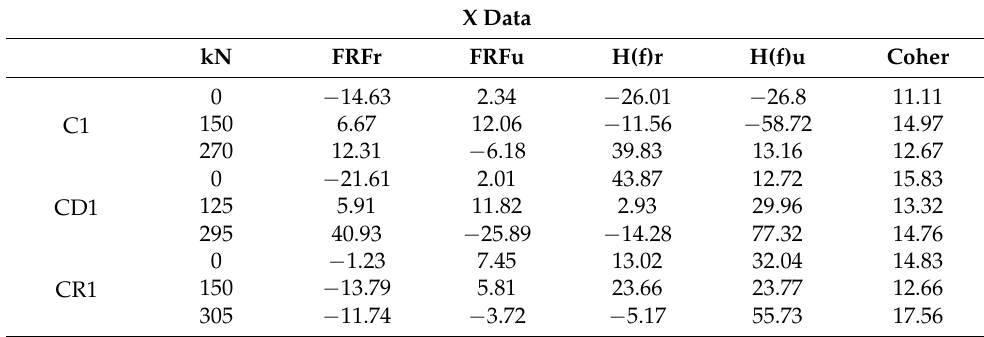
Table 2. Numerical data for 5 signal measures for different loads on the tested segments. X